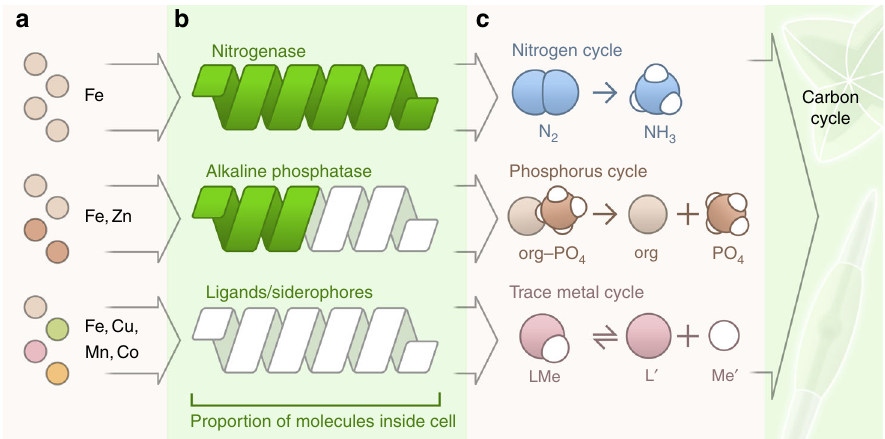
Fig. 6 Biological responses of phytoplankton and bacteria to aerosol trace metals. Trace metals are required as co-factors for many biogeochemically important molecules. Certain aerosol trace metals ( a ) have been shown to stimulate production of nitrogenase 73,77 , alkaline phosphatase 91 and metal- binding ligands 70,95,162 , and these molecules may remain within the cells (proportion of helix which is green) or be exuded into the sea water ( b ), where they catalyze chemical reactions that in fl uence biogeochemical cycles ( c ). The cycling of N, P, and trace metals in turn affects the carbon cycle by in fl uencing cellular growth rates. See Supplementary table 2 for compilation of studies, which this fi gure